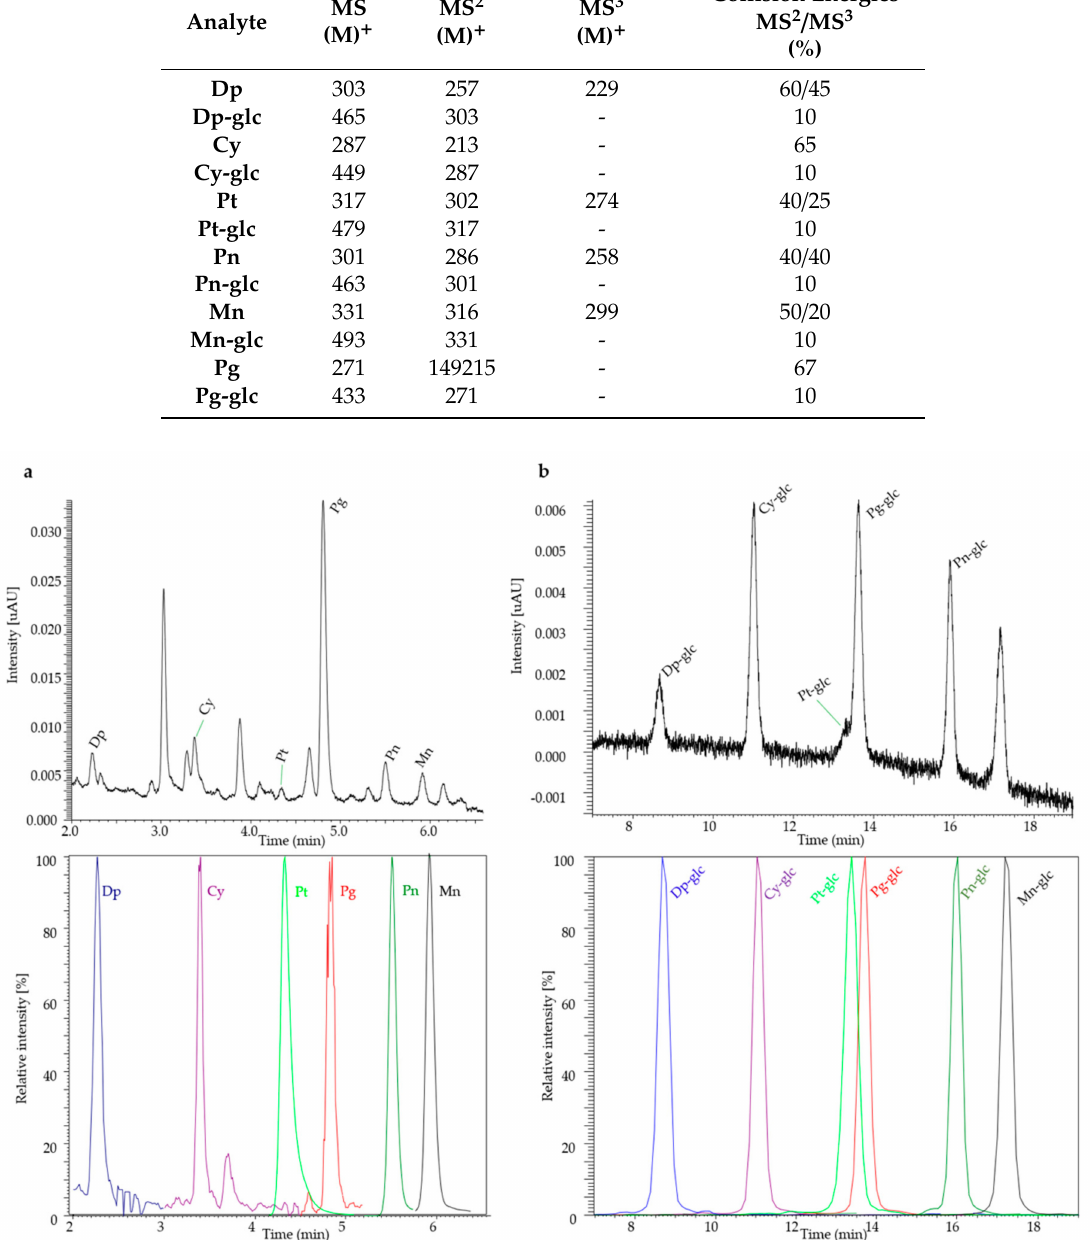
Figure 2. Chromatographic profiles (top: UV at 520 nm; bottom: extracted ion chromatograms) of ( a ) anthocyanidins in urine and ( b ) anthocyanins in plasma. (Dp ( m / z ) 303 → 257 → 229; Cy ( m / z ) 287 → 213; Pt ( m / z ) 317 → 302 → 274; Pg (m / z ) 271 → 149 and 215; Pn ( m / z ) 301 → 286 → 258; Mn ( m / z ) 331 → 316 →